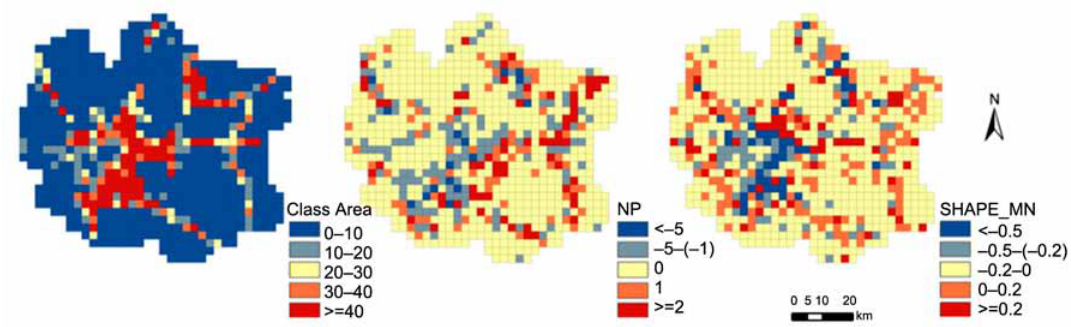
Fig. 12. Binary comparison between BUS scenario and observed urban landscape pattern 2010 in Class Area, NP, and SHAPE_MN